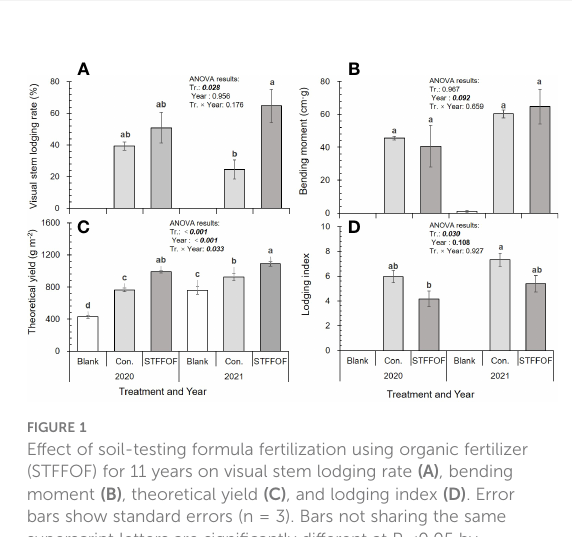
FIGURE 1 Effect of soil-testing formula fertilization using organic fertilizer (STFFOF) for 11 years on visual stem lodging rate (A) , bending moment (B) , theoretical yield (C) , and lodging index (D) . Error bars show standard errors (n = 3). Bars not sharing the same superscript letters are signi fi cantly different at P <0.05 by Duncan ’ s post-hoc comparison. ANOVA results of bending moment, lodging index, and visual stem lodging rate regarding blank, control, and STFFOF treatments are included in the fi gure.